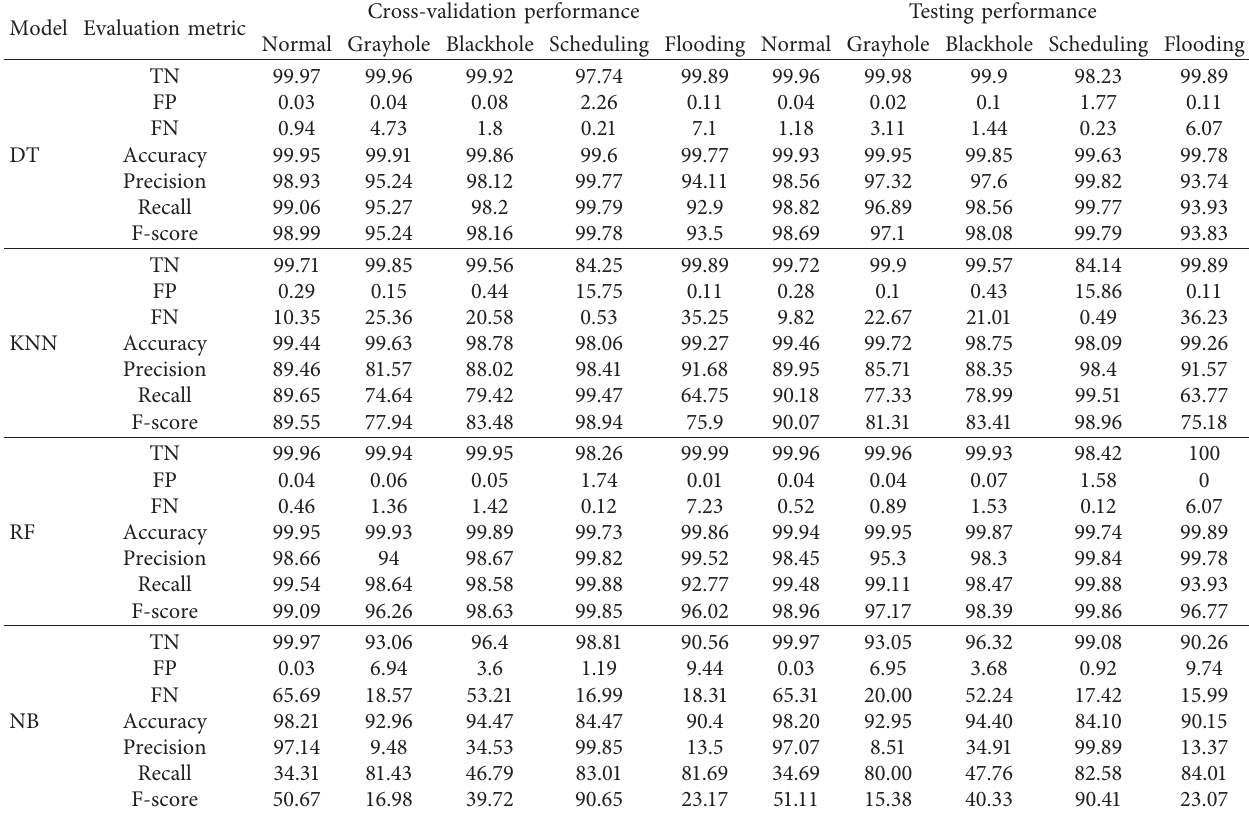
Table 10: The performance of machine learning for WSN dataset using all features. Model Evaluation